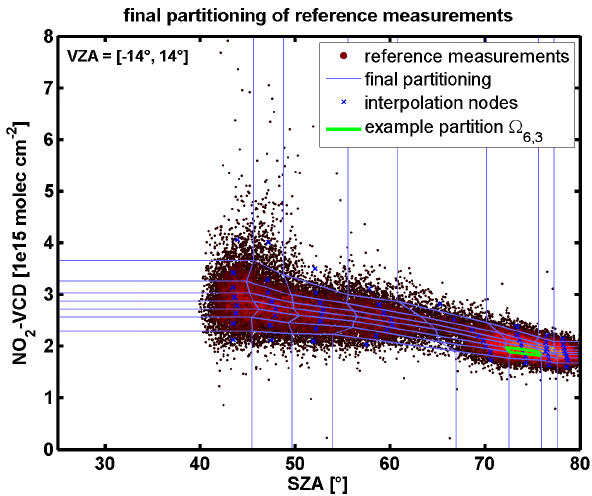
Fig. 3. Partitioning of GOME-2 reference measurements (colour- coded density) in the (ϑ,V N ) -plane for the near-nadir direction ( | ψ | ≤ 14 ◦ ) for 25 March 2009. Each partition contains an almost equal number of measurements from which BrO/O 3 SCD ratios are retrieved. The example partition (cid:127) 6 , 3 is depicted in Fig. 4. The mean of measurements within each partition (blue crosses) is used as nodes for interpolating the results (Fig. 5).